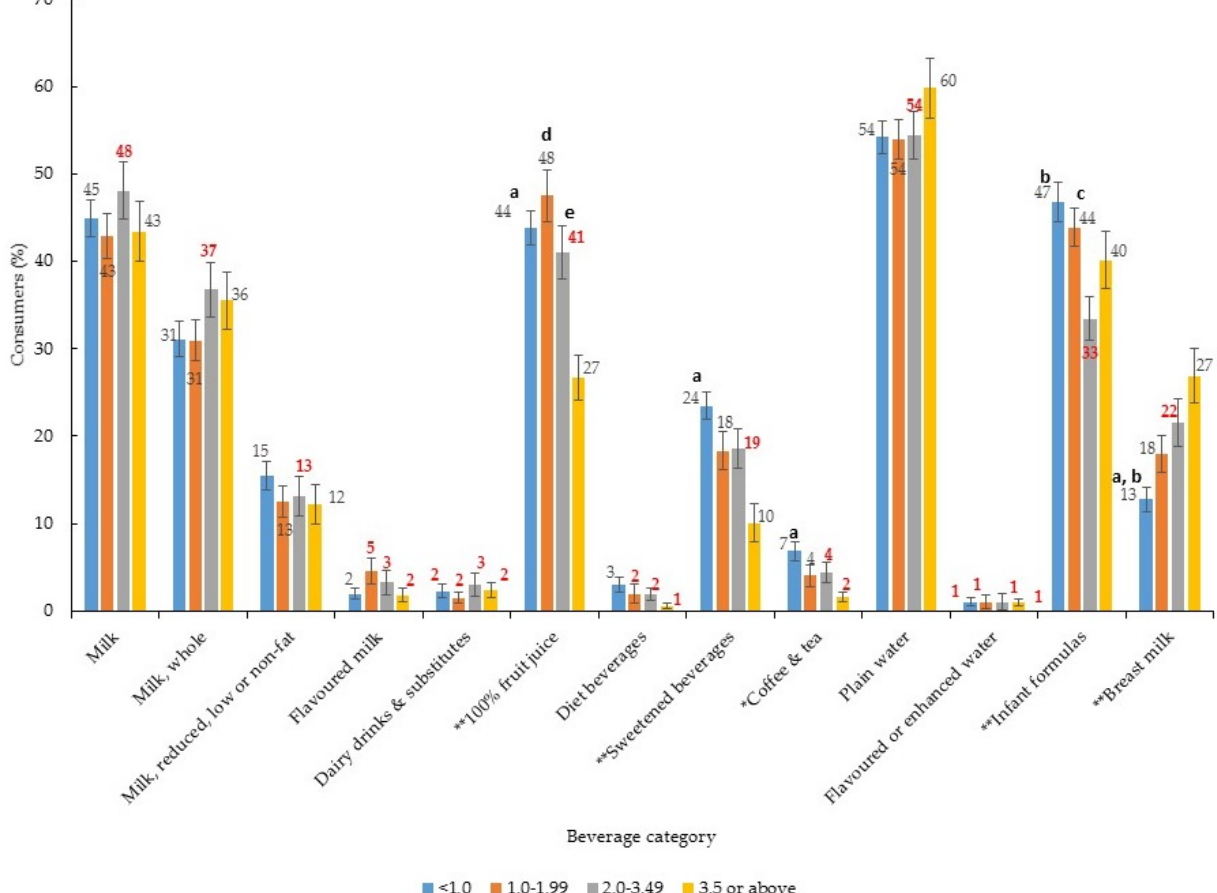
Figure 4. Proportion (%) of children consuming each type of beverage by poverty–income ratio ( n = 2554) 1,2,3 . 1 Error bars represent ± 1 SE. Those bolded in red are statistically unreliable, relative standard error ≥ 30% [24]; 2 Chi-square test to assess difference in proportions * p < 0.01, ** p < 0.001. Where significant, logistic regression with Bonferroni adjustment for multiple comparisons was used to assess differences between sub-groups; a PIR < 1.0 vs. PIR ≥ 3.5, p < 0.05; b PIR < 1.0 vs. PIR 2.0–3.49, p < 0.05; c PIR 1.00–1.99 vs. PIR 2.0–3.49, p < 0.05; d PIR 1.00–1.99 vs. PIR ≥ 3.5, p < 0.05; e PIR 2.00–3.49 vs. PIR ≥ 3.5, p < 0.05; 3 Includes those participants with data for